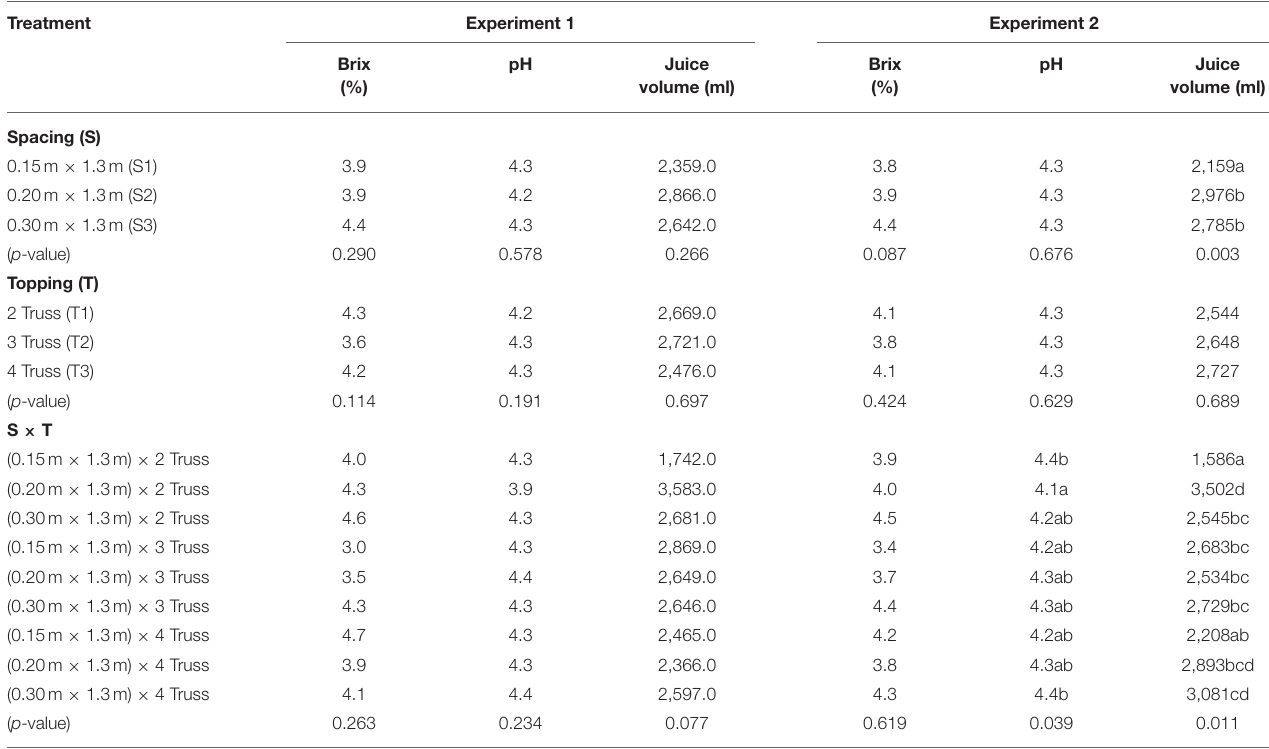
TABLE 10 | Effect of spacing and topping on fruit quality of Solanum lycopersicum under greenhouse conditions.